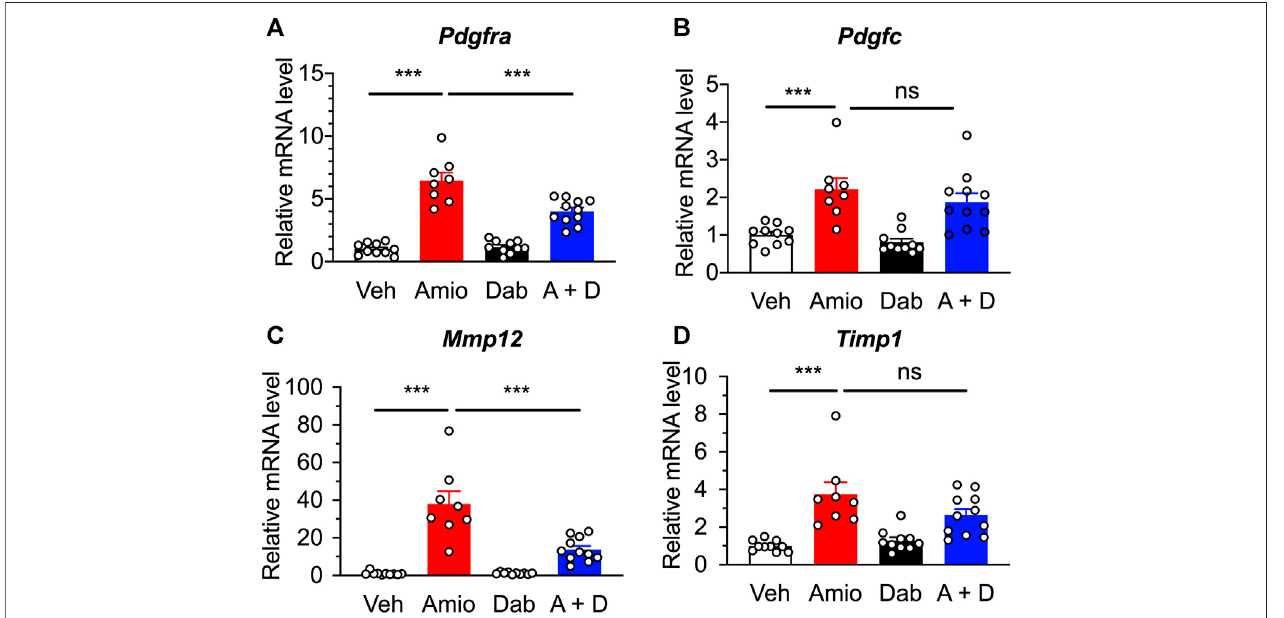
FIGURE 5 | Quantitative RT-PCR results showing the expression of in fl ammation-associated genes in the lung of mice after a repetitive, oral treatment with amiodarone (Amio, 300 mg kg − 1 day − 1 ) and dabigatran (Dab, 60 mg kg − 1 day − 1 ) or both (A + D) 5 times per week for 4 weeks. Expression levels of Pdgfra (A) , Pdgfc (B) , Mmp12 (C) ,and Timp1 (D) werenormalized totheexpression of Pum1 ineach samplefrom individual mouse ( n (cid:1) 8 – 11), and are representedasthe relative ratioto those of vehicle group (Veh). Individual data are shown with the mean ± SEM. Statistical signi fi cance was tested by one-way ANOVA with Tukey ’ s multiple comparisons. ***, p < 0.001; ns, not signi fi